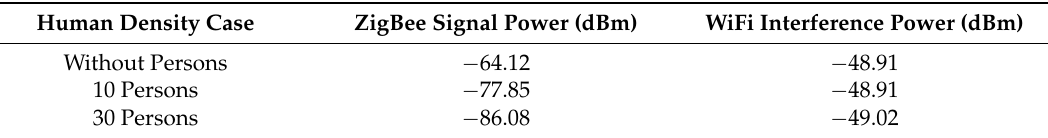
Figure 16. Estimated SNR values for different configurations of the Tx-Rx wireless link when the WiFi 4 access point is interfering. Table 4. Simulation results at receiver point (Rx) for ZigBee transmitting 10 dBm and WiFi transmitting 20 dBm.